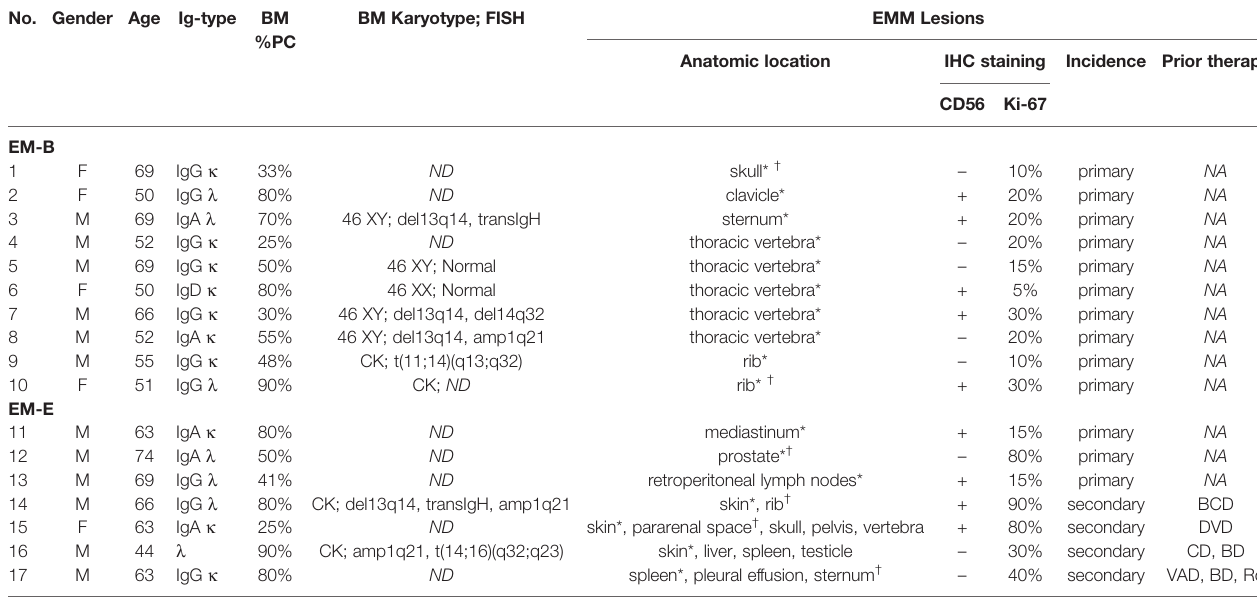
TABLE 1 | Patient Characteristics ( n =